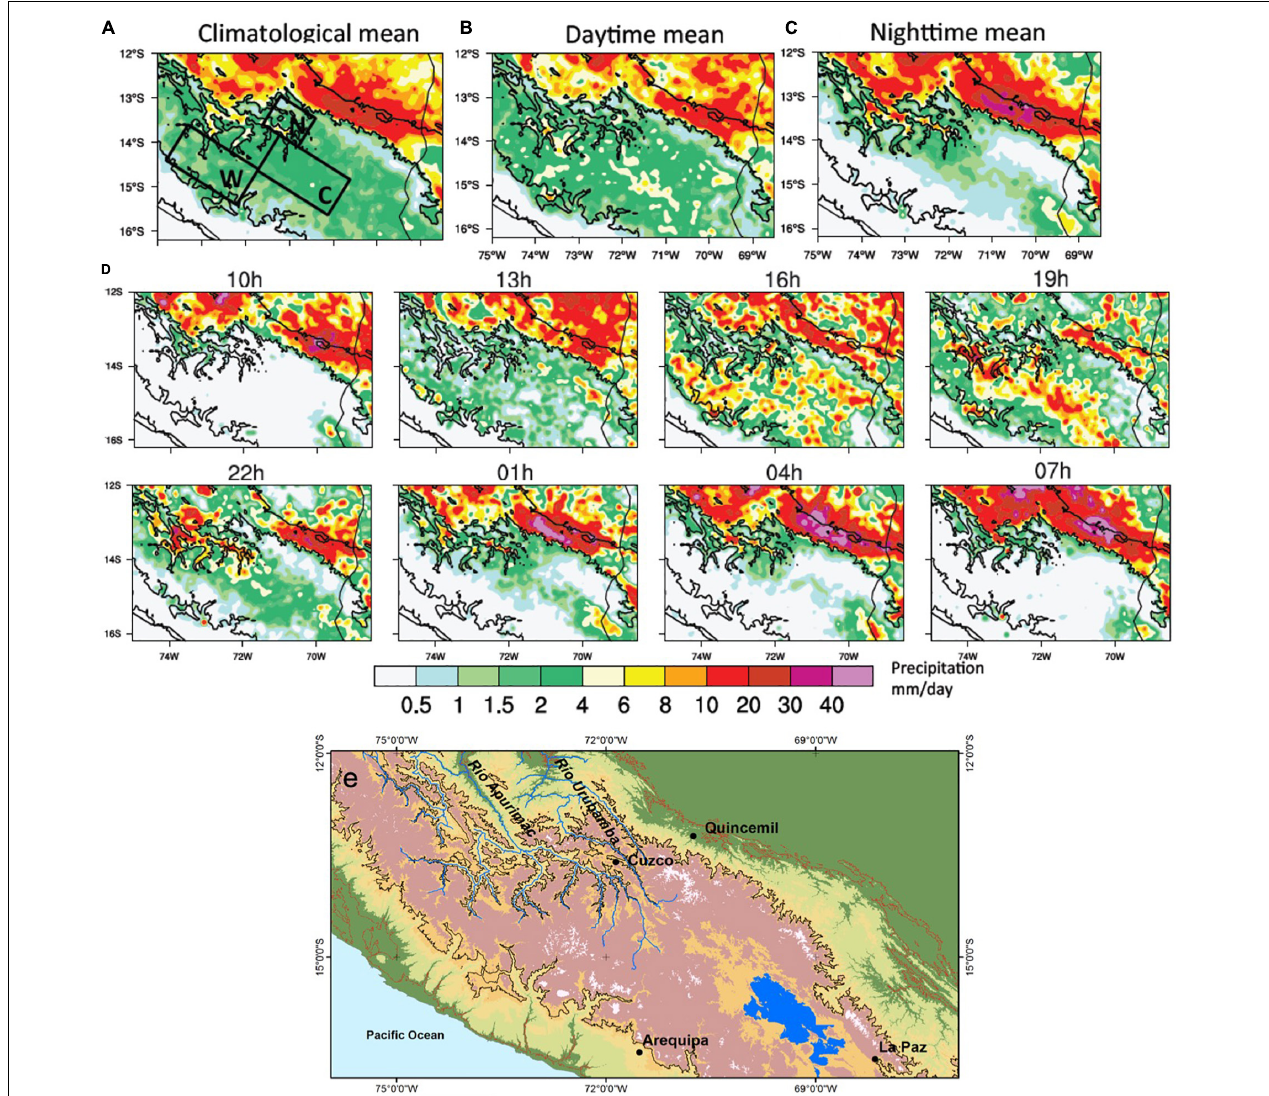
FIGURE 9 | Mean December-February precipitation estimated by the precipitation radar of the Tropical Rainfall Measuring Mission (TRMM-2A25) for the 2000–2014 period (mm/day) in the Peruvian Andes (Cuzco region), corresponding to (a) all times step mean, (b) daytime mean [7–19 h Local Time (LT)], (c) nighttime mean (19–7 h LT), (d) 3 h times-step mean. Bold black contours show 500 and 3500 m orography limits. The black boxes indicated in (a) define the West (W), Center (C), and North (N) boxes. In (d) , the indicated time-step titles are 10 h (7–10 h mean), 13 h (10–13 h mean), 16 h (13–16 h mean), 19 h (16–19 h mean), 22 h (19–22